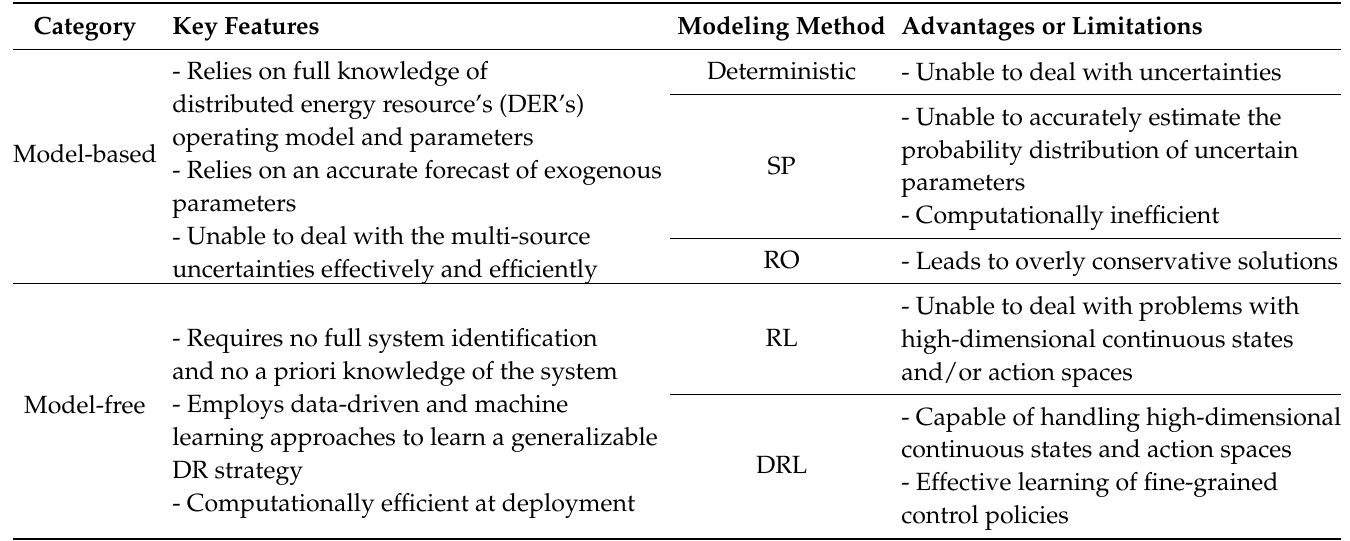
Table 1. Summary of the existing methods used in optimal demand response (DR)